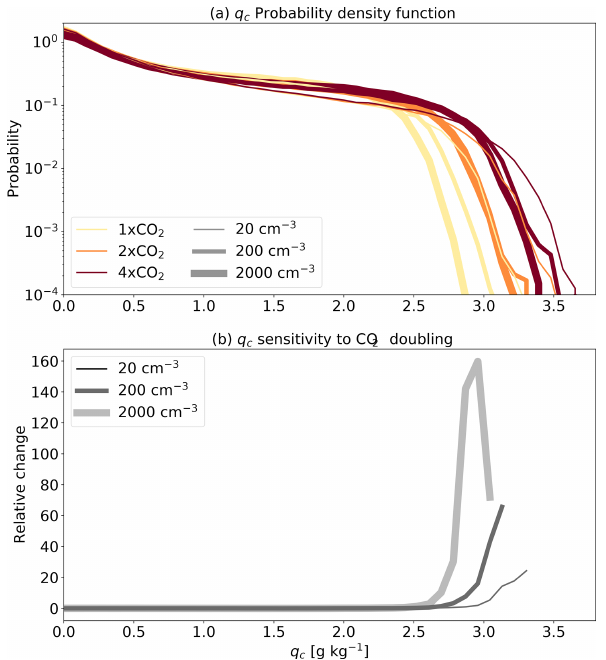
Figure 6. Probability density functions (PDFs) of the cloud droplet mixing ratio ( q c ) for the different simulations (a) and the mean sensitivity of the q c PDF to a doubling of the CO 2 concentration based on the three combinations available for each N a condition (2 × CO 2 − 1 × CO 2 , 4 × CO 2 − 2 × CO 2 and (4 × CO 2 − 1 × CO 2 ) / 2) (b) , calculated for the heights around which the cloud droplet effective radii reach a maximum (1950m) and using 3-D files output every hour of the last 150d of the simu- lations. Note the logarithmic scales for the y axes of (a) .